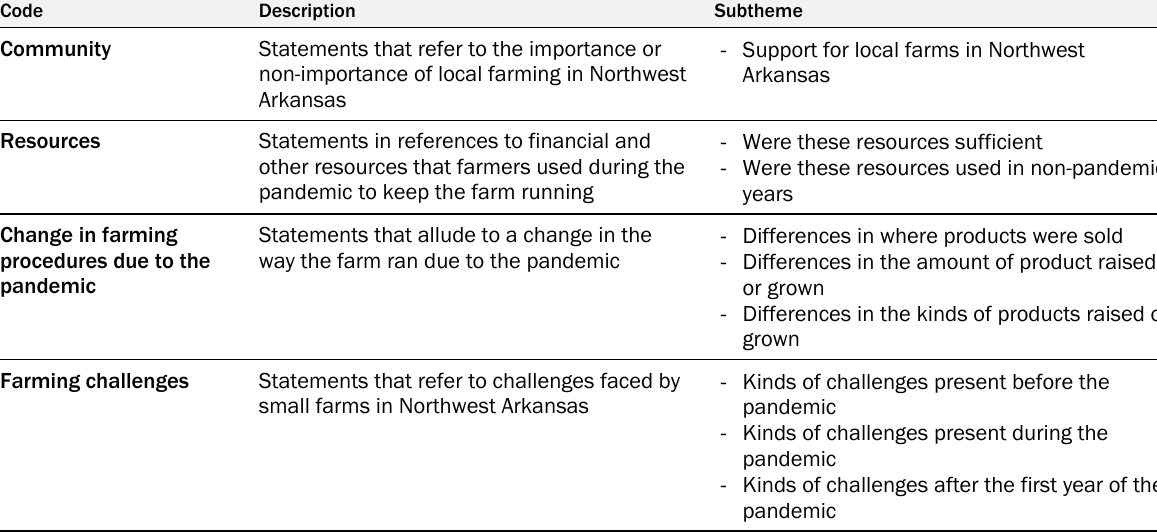
Table 1. Qualitative Coding